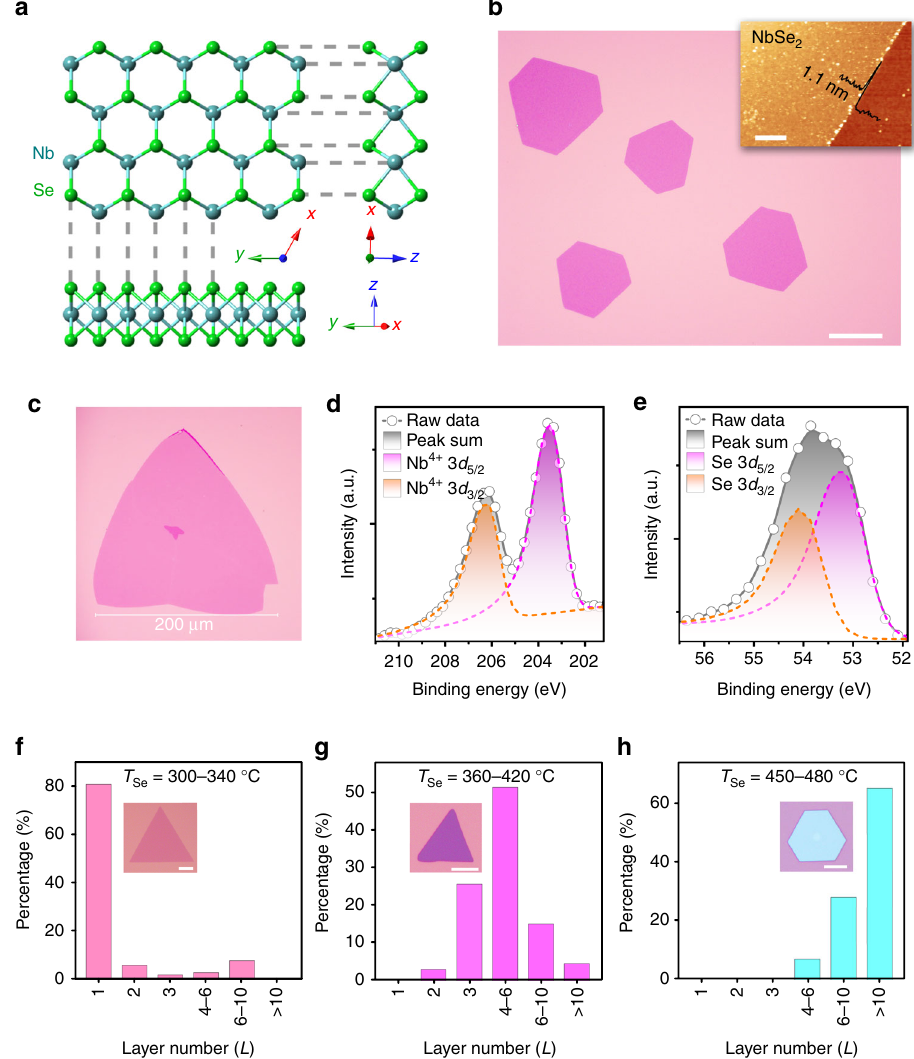
Fig. 1 Atomic structure, morphologies, and characterizations of NbSe 2 crystals. a Ball-and-stick model of monolayer 2 H -NbSe 2 viewed from three different directions. b Optical image of uniform NbSe 2 crystals deposited on a SiO 2 /Si substrate. Scale bar , 40 µ m. A representative AFM image ( inset ; scale bar